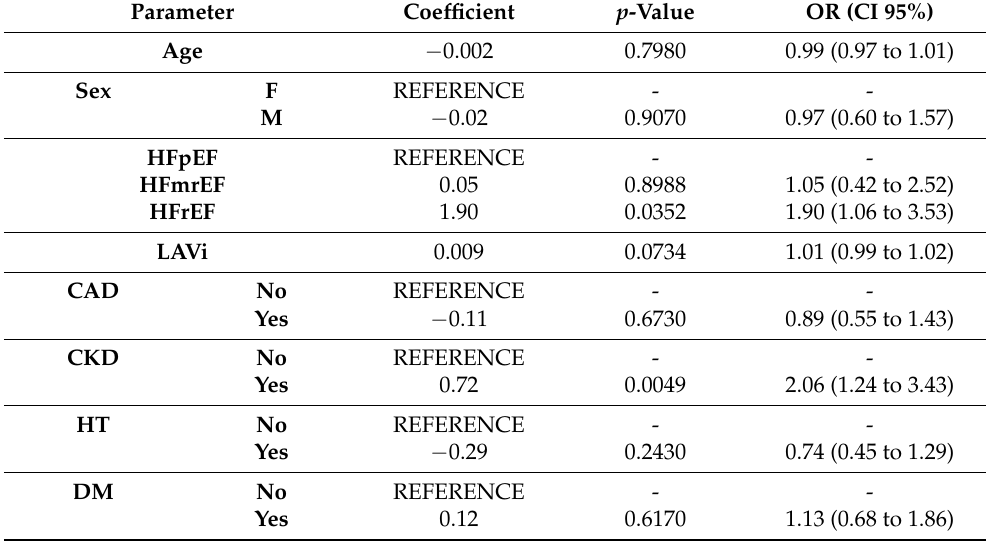
Table 3. Predictors for increased E/e (cid:48) ratio in patients with HF and AF (univariate binary simple logistic regression).